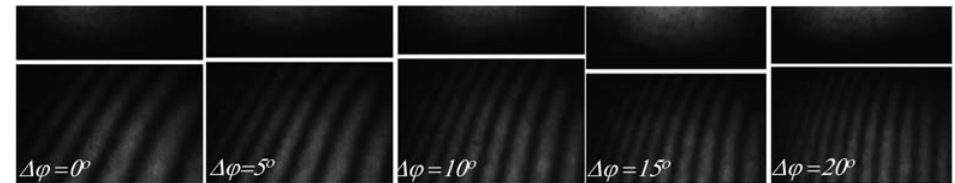
Figure 4. Experimentally obtained interference patterns indeed change when the angle of orientation of the Dove prism increases from 0 to 20 ◦ for an off-axis point source. The nearly straight interference fringes increase in density and increase in the inclination angle when the shear angle is increased in increments of 5 ◦ . This is one of the characteristics of the RSI in measuring the tilted wave fronts, such as those originating at an off-axis planet. This experimental data confirms that an off-axis source can be detected in an RSI by generating straight fringes. Furthermore, the fact that the fringes arise from an off-axis source, rather than because of an artifact, may be confirmed by changing the shear angle and observing how their density and angle of inclination change.